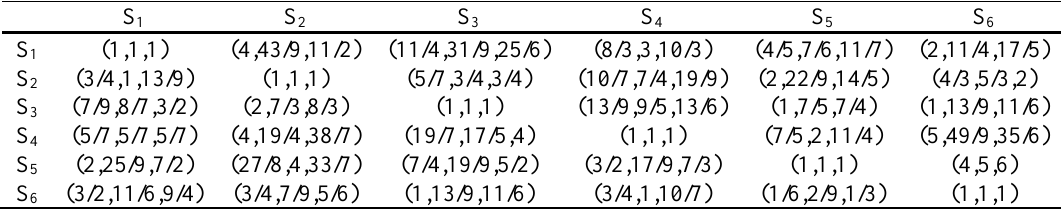
Table 9. Pair wise contribution matric “Supplier